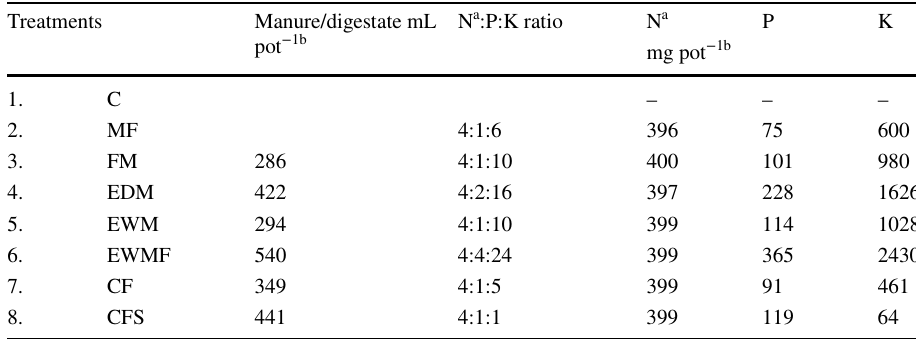
a Inorganic N only per soil column in the soil column